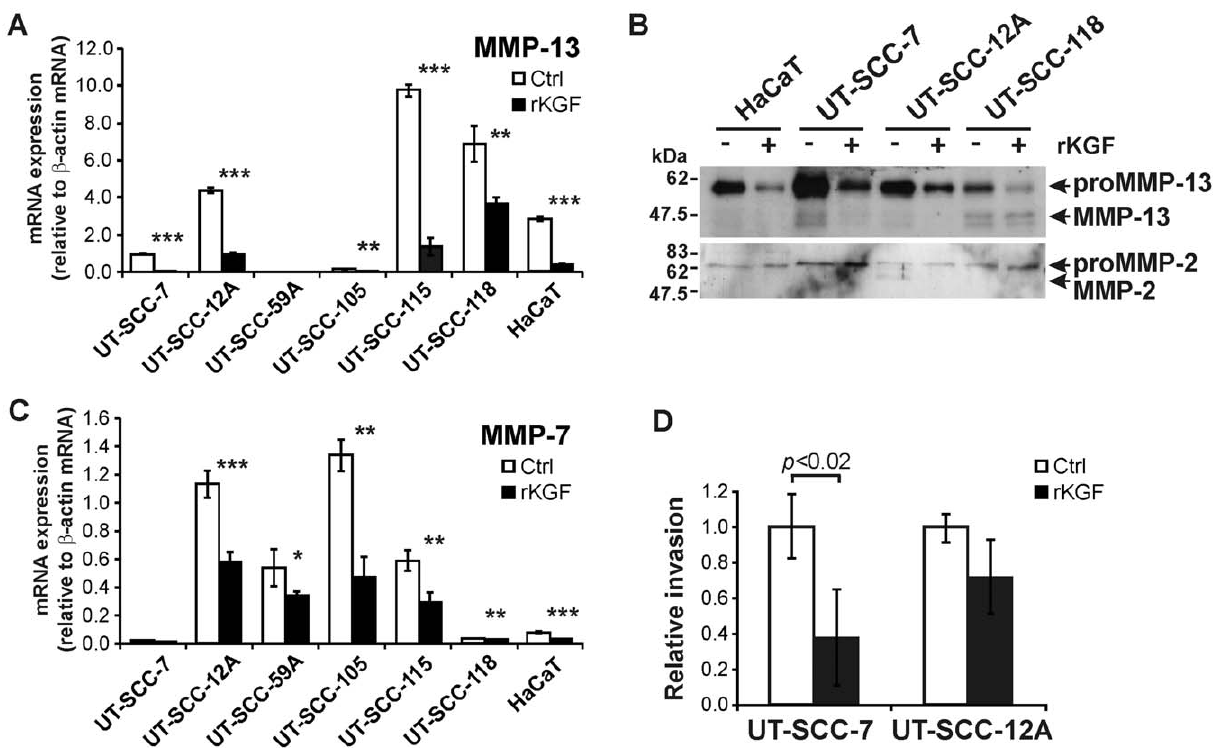
Figure 5. KGF downregulates the expression of MMP-13 and MMP-7 and suppresses invasion of cutaneous SCC cells. ( A, C) Cutaneous SCC cell lines (UT-SCC-7, - 12A, -59A, -105, -111, and -118) and HaCaT cells were serum starved and treated with recombinant KGF (rKGF; 10 ng/ml). After 24-h treatment, total RNA was extracted and analyzed for the expression of MMP-13 ( A ) and MMP-7 ( C ) mRNA by qPCR. The results were normalized for b -actin mRNA levels in the same samples. * p , 0.05, ** p , 0.01, *** p , 0.0001, with independent samples T-test, n=3–4. ( B ) HaCaT cells and cutaneous SCC cells (UT-SCC-7, - 12A, and -118) were incubated with recombinant KGF (rKGF) for 72 h, and the medium samples were analyzed for MMP-13 and MMP-2 protein using western immunoblotting. Each pair of control and KGF-treated sample contain equal amount of total protein. ( D ) Cutaneous SCC cells (UT-SCC-7, -12A) (3 6 10 5 cells) treated with KGF (10 ng/ml) for 24 h were applied in collagen gel coated invasion chamber and incubated for 48 h in the presence of KGF. The cells that had invaded through collagen matrix were stained, photographed and counted. Statistical analysis with independent samples T-test, n=4–6.